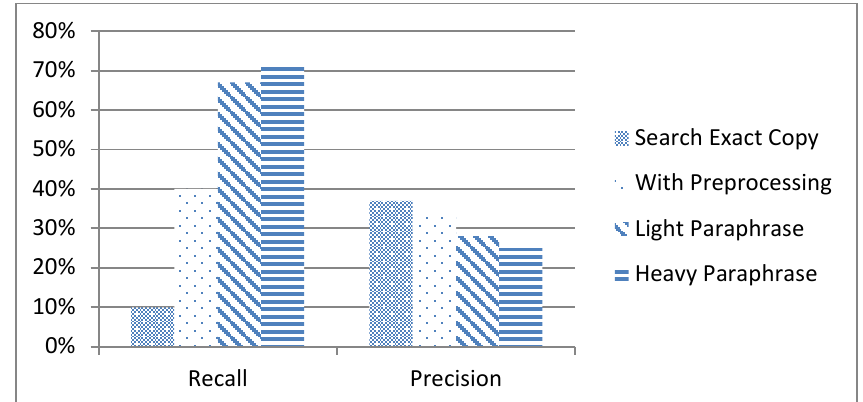
Figure 14. Evaluating ParaMaker in Persian language on Prozhe.com